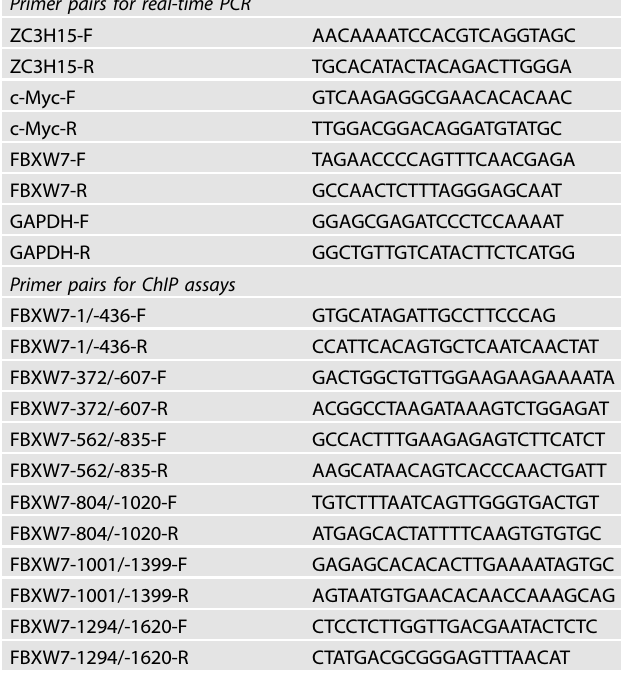
Table 1. Primer pairs for real-time PCR and ChIP